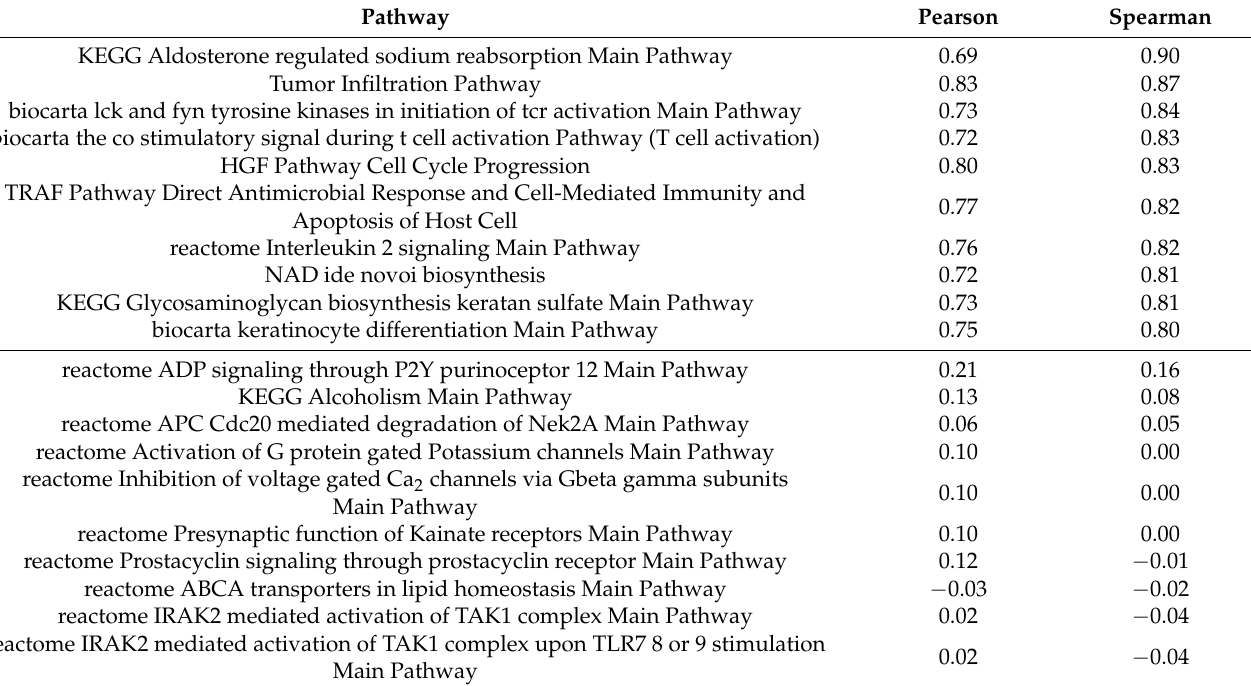
Table 5. “Top-10” of the most and the least correlated molecular pathways for RNA and protein expression levels calculated for Ovarian Serous Cystadenocarcinoma biosamples.